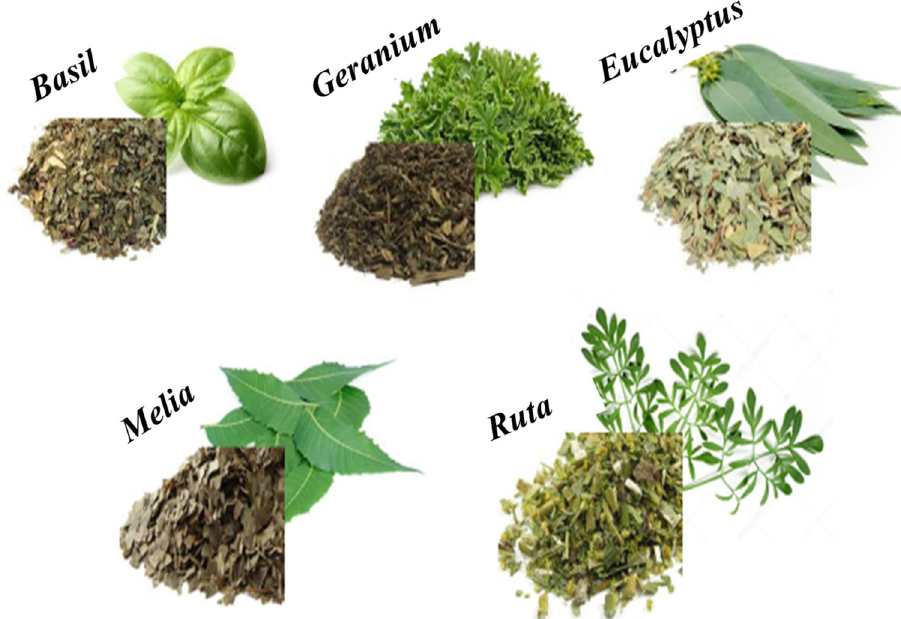
Figure 8. Plants used in the synthesis of AgNPs.